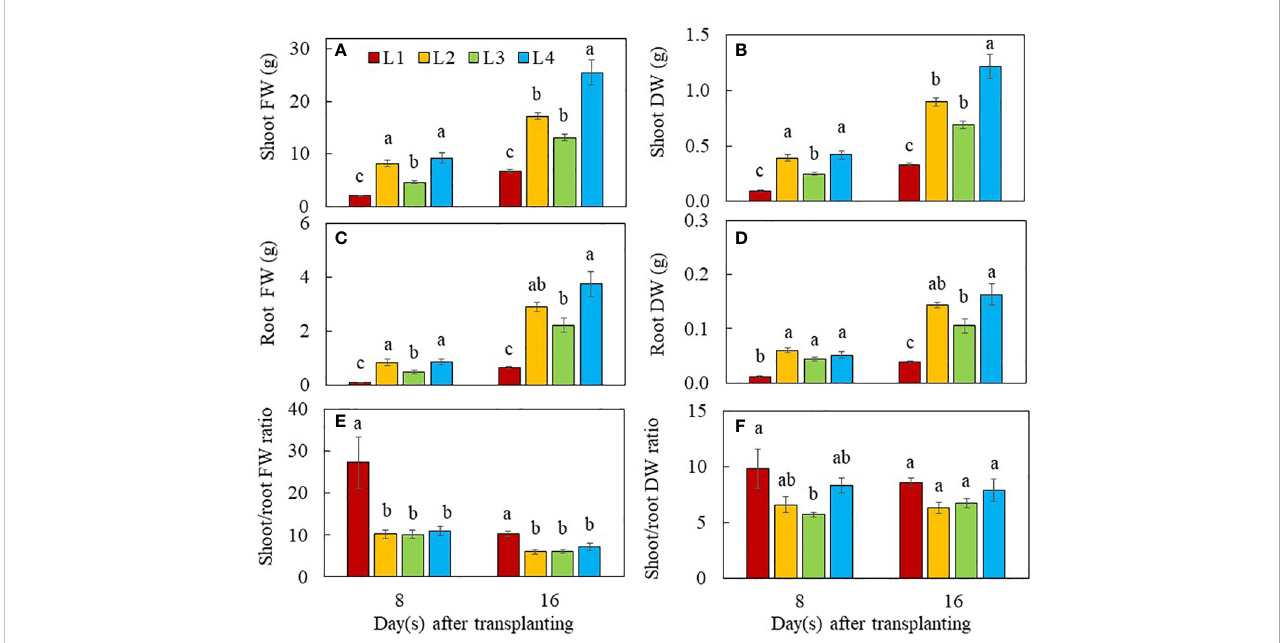
FIGURE 2 Shoot FW (A) , shoot DW (B) , root FW (C) , root DW (D) , shoot/root FW ratio (E) and shoot/root DW ratio (F) of purslane grown under different light conditions for 8 and 16 days. Values are means ± standard errors. Means with different letters are statistically different ( p <0.05; n =5) as determined by Tukey ’ s multiple comparison test for each day. Refer to Figure 1 for the different conditions of L1, L2, L3 and L4.